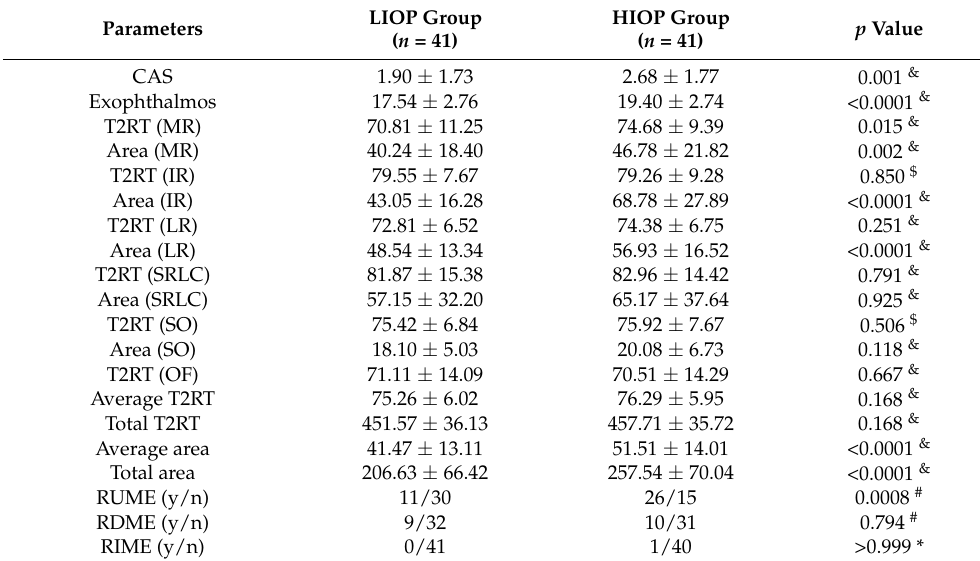
Table 2. Ocular characteristics of TAO patients in 2